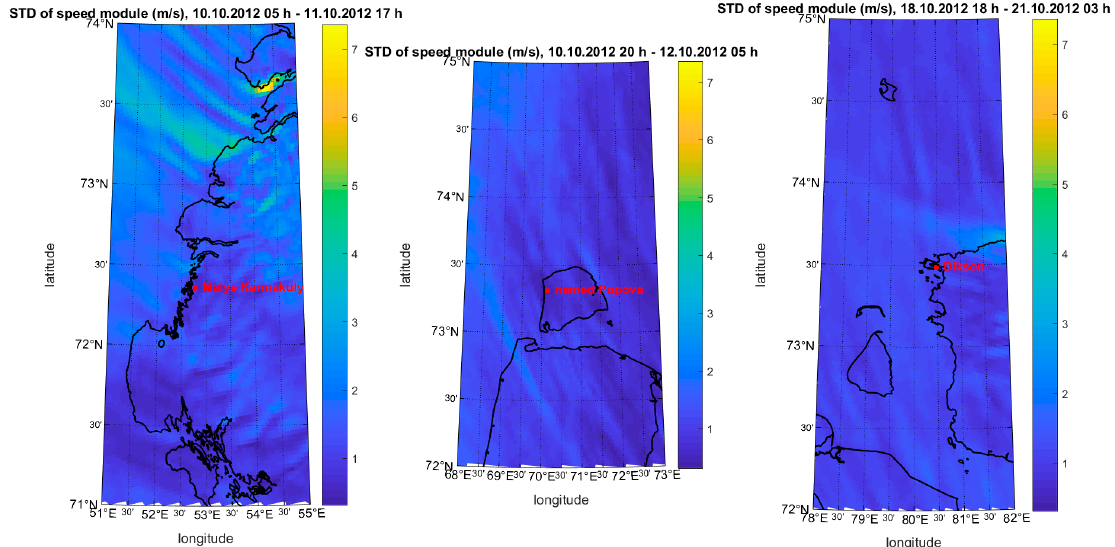
Figure 10. Standard deviation of wind speed module (m / s) for 21, 30, and 17 h periods at three considered regions, ≈ 3 km grid.